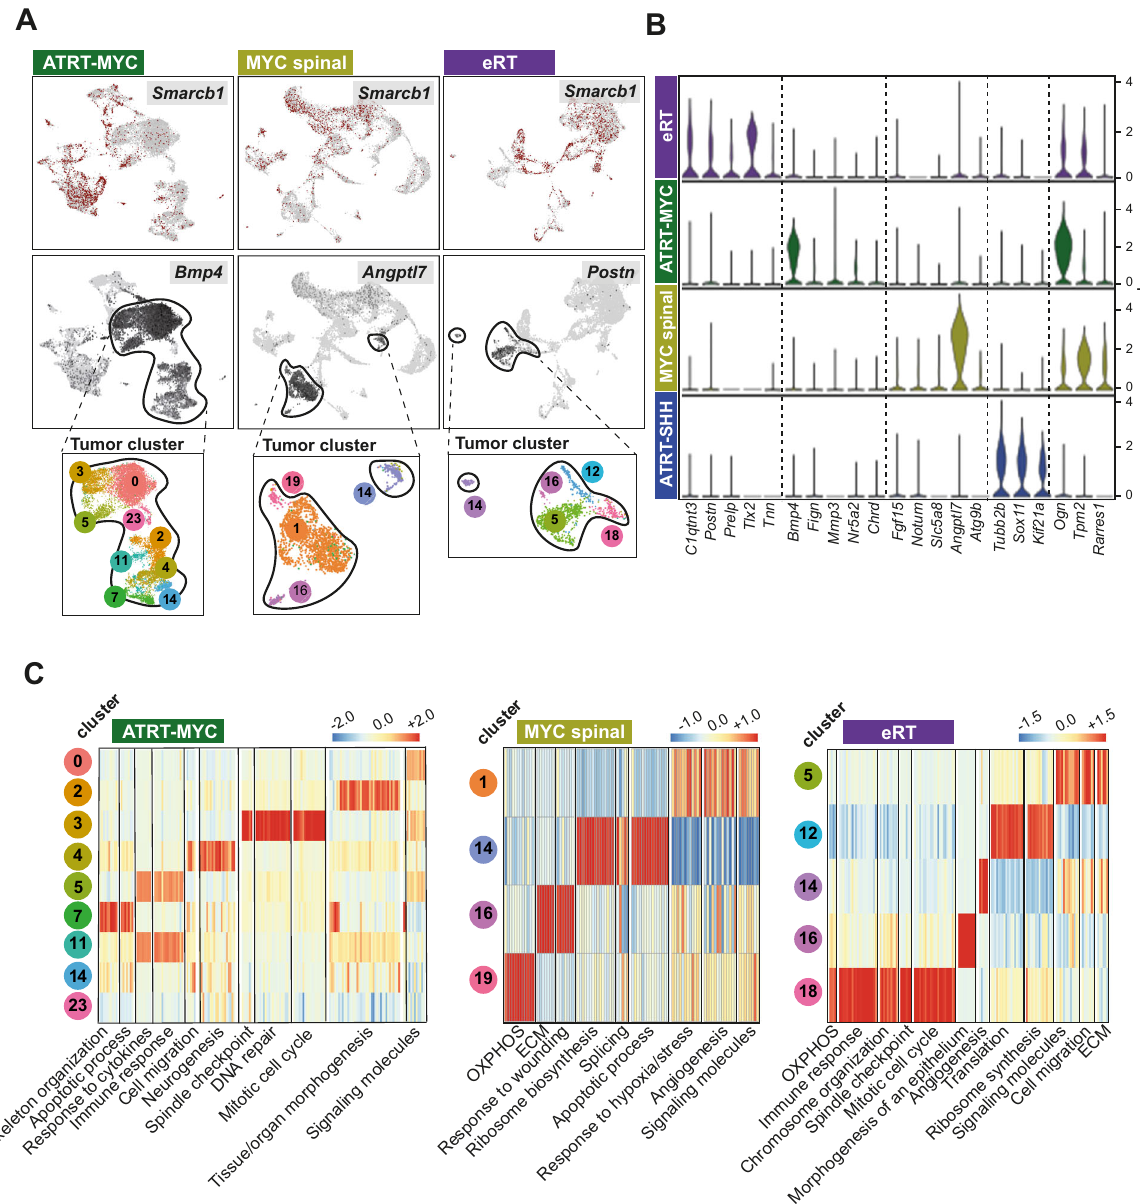
Fig. 3 RT of different localizations share repetitive transcriptional programs. A UMAP plots show clustering of murine MYC tumor single-cell transcriptomes subdivided into ATRT-MYC (left, n = 5 samples), MYC tumors from the spinal canal (middle, referred to as MYC spinal, n = 3 samples) and eRT (right, n = 3 samples). Smarcb1 -negative tumor cells (upper row) and expression of the exemplary MYC subtype-speci fi c genes depict tumor clusters (TCs) (circled clusters, TC numbers are indicated in magni fi ed insets). B Violin plots depict gene expressions of top-ranked localization-speci fi c tumor markers derived from DE analysis comparing only tumor cells of all three MYC subtypes. C Heatmaps show the upregulated expression of functional gene classes across individual TCs of the three MYC subtypes. See also Supplementary Fig. 6 and source data fi le.